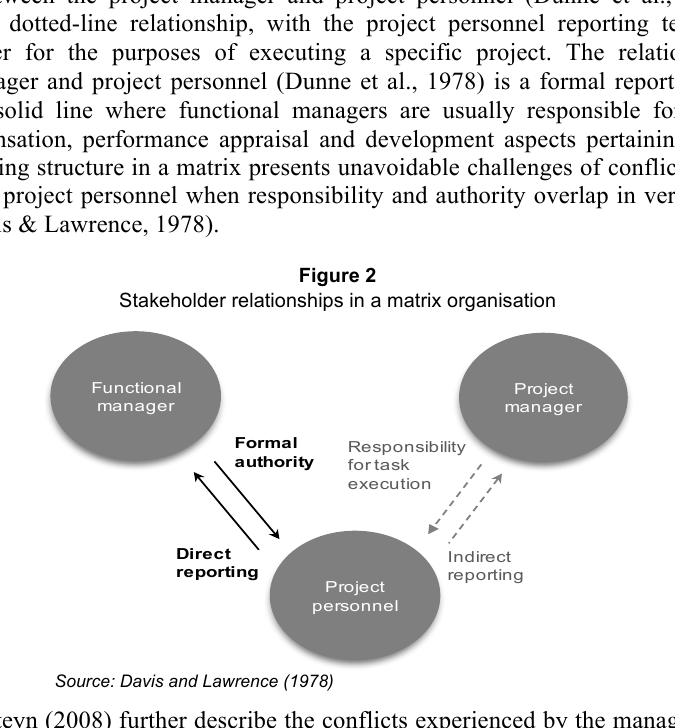
Source: Davis and Lawrence